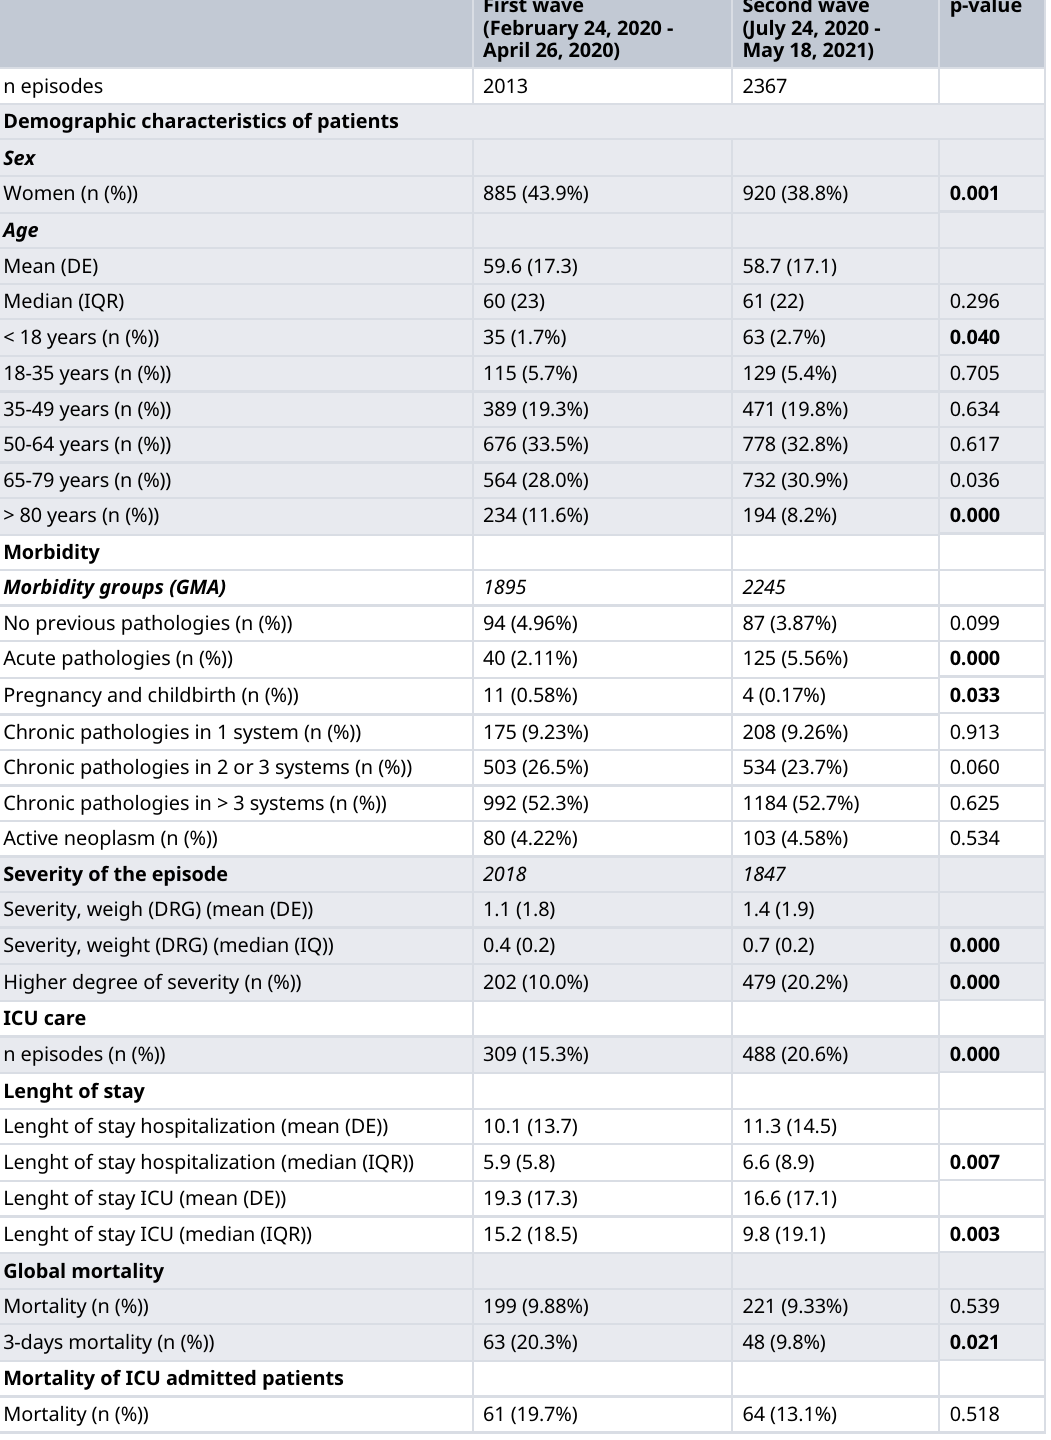
Table 2. Characteristics, severity and mortality of COVID-19 hospitalised patients. IQR = interquartile range. Bold p-values represent statistically significant